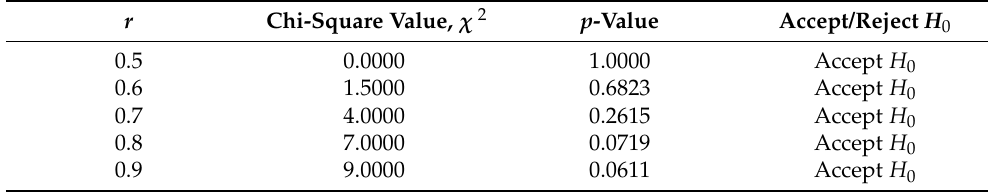
Table 20. Friedman test between r 2SAT nand − ABC with all comparison algorithms. r Chi-Square Value, χ 2 p